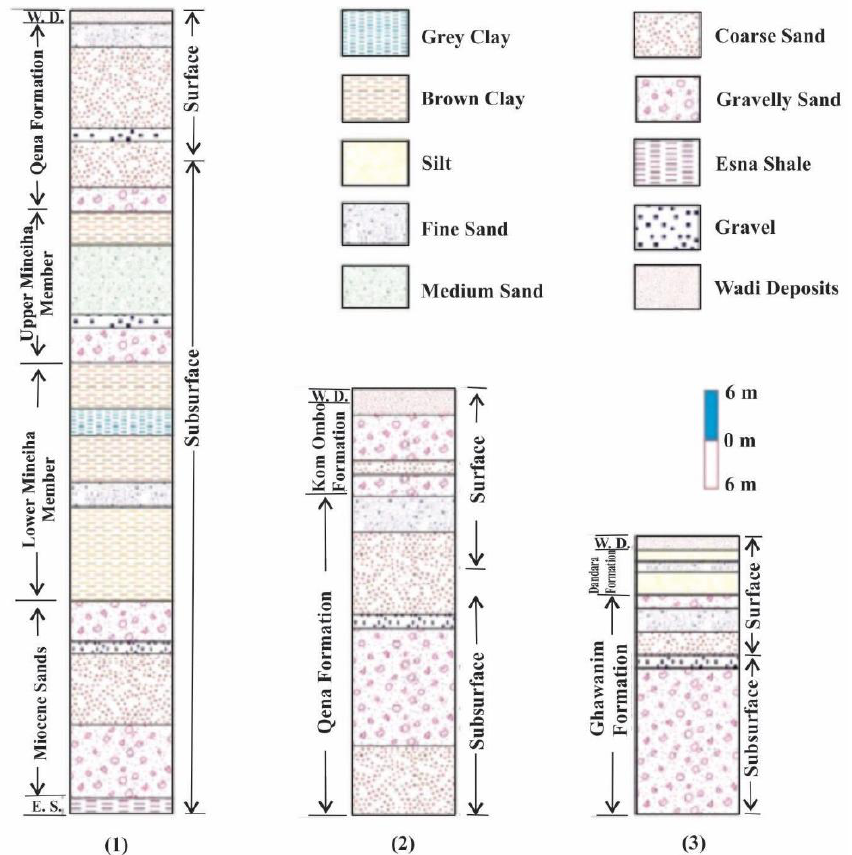
Figure 3. The stratigraphic sequence west of Abydos area [62]. In this figure, the geologic formations of the study region are arranged chronologically.